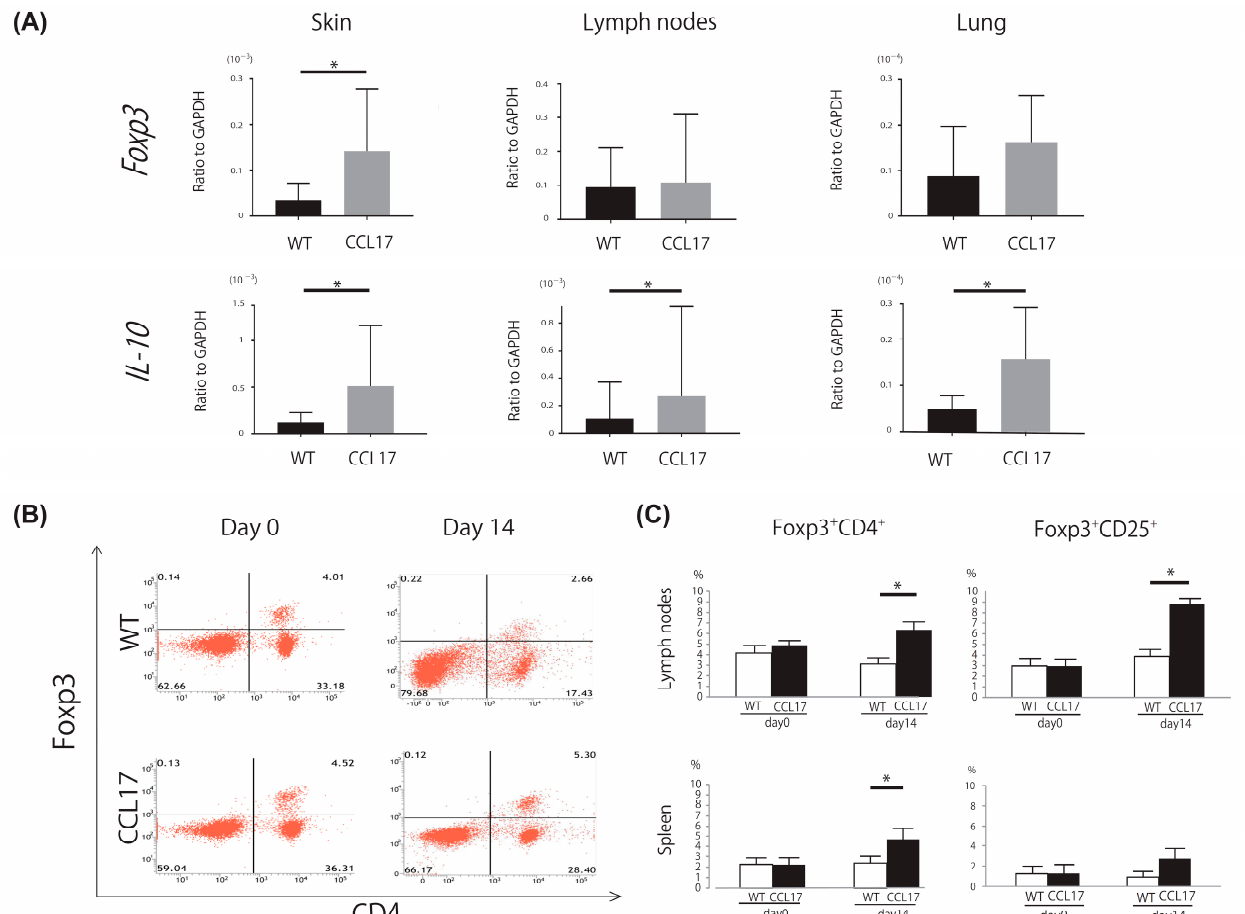
Figure 3. Regulatory T cells (Tregs) were increased in skin tumors, draining lymph nodes, and lung metastasis of CCL17 transgenic (TG) mice. Skin tumors, draining lymph nodes, and spleen were harvested 14 days after subcutaneous injection of B16F1 melanoma cells, while metastatic lung tissues were harvested 21 days after intravenous injection of B16F1 melanoma cells. Expression levels of markers of Tregs were evaluated by quantitative reverse transcription-PCR in skin tumors, draining lymph nodes, and metastatic lung tissues from wild-type (WT) mice and CCL17 TG mice. The frequency of Tregs was analyzed by flowcytometric approach in lymph nodes and spleen from WT mice and CCL17 TG mice. ( A ) Foxp3 mRNA levels were significantly higher in skin tumors of CCL17 TG mice than those of WT mice. IL-10 mRNA levels were significantly upregulated in skin tumors, lymph nodes, and metastatic lung tissues of CCL17 TG mice compared with those of WT mice. ( B ) Representative flowcytometric images showing the frequency of Foxp3 + CD4 + cells in the draining lymph nodes from WT mice and CCL17 mice on days 0 and 14 after tumor injection. ( C ) The frequency of Foxp3 + CD4 + cells was significantly increased in lymph nodes and spleen on day 14. The frequency of Foxp3 + CD25 + cells was significantly upregulated in lymph nodes on day 14. Data are presented as mean ± SEM of three independent experiments ( n = 6 for each group). * p < 0.05 WT versus CCL17 TG mice.